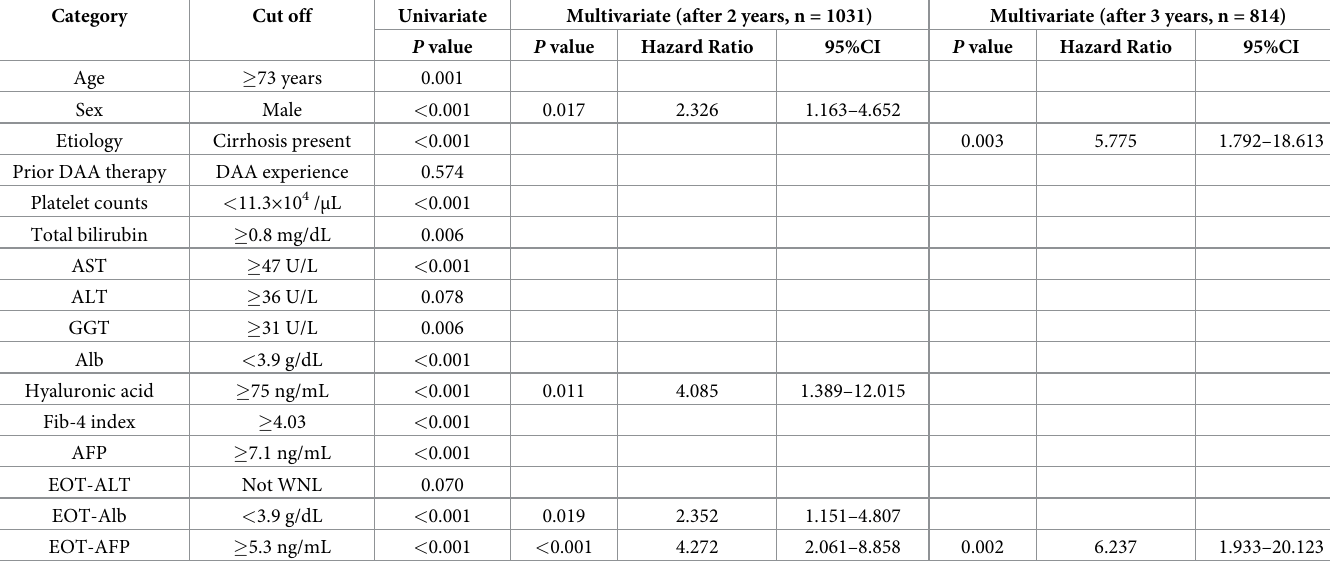
Table 5. Factors associated with the development of hepatocellular carcinoma (HCC) in over 2-year or 3-year follow up model. Category